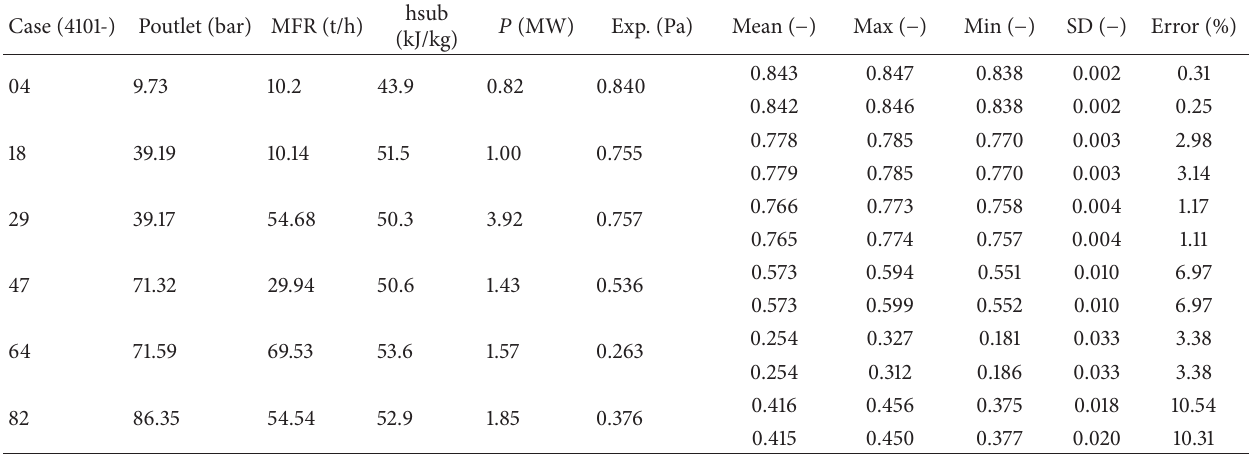
Table 7: Input parameter combinations and uncertainty results for the void fraction